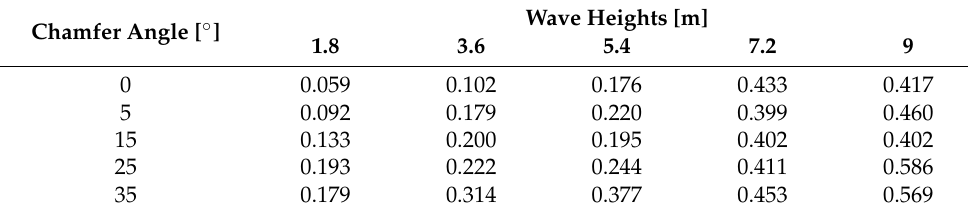
Table 6. Mean absolute deviation between the motion in Z direction in each case [m]. Chamfer Angle [ ◦